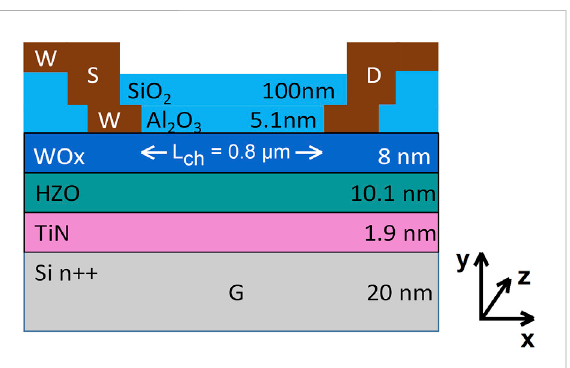
FIGURE 1 Epitaxial structure of the HZO-based, back-gated FeFET which serves as a calibration reference for this work (Halter et al., 2020).The ferroelectricHZO gate dielectric, theWO x channel, the source (S), the drain (D), and the gate (G) regions are indicated. The thickness of all layers and the channel length are giveninnanometersandmicrometers,respectively.Notethatonly 2-D structure is used during